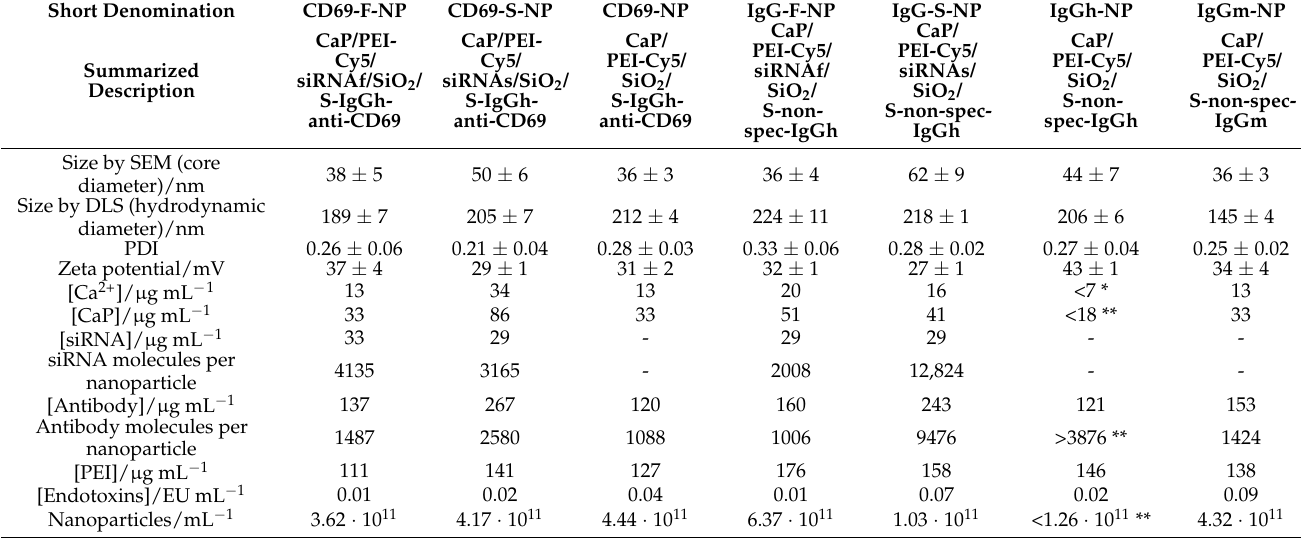
Table 2. Characterization data of antibody-decorated calcium phosphate nanoparticles used for in vitro cell targeting and gene silencing of p65 NF- κ B in lymphocytes. For characterization of reference nanoparticles and abbreviations, see Table